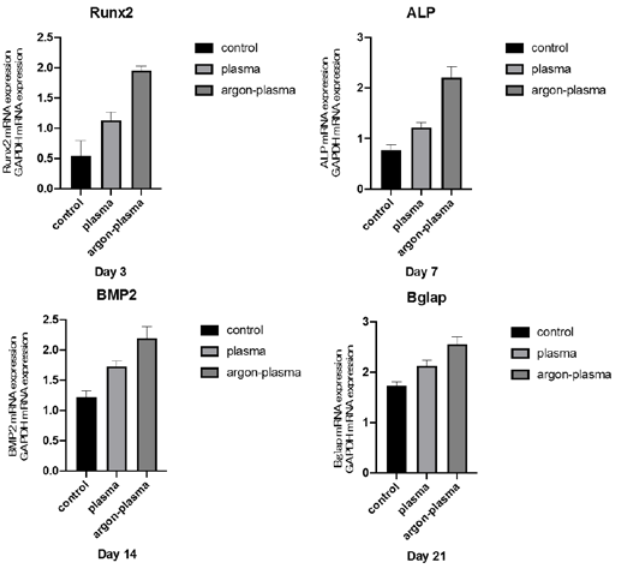
Figure 7. The gene expression related to the induction of hard tissue differentiation on the material surface of the samples in the test and control groups were analyzed. In this experiment, the assay was performed at a measurement time specific to each gene. Significantly higher gene expression was observed on the material surface of the samples in the argon plasma-treated group, among all three groups, at all measurement time points.